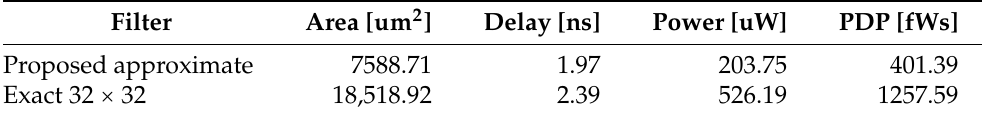
Table 2. Synthesis